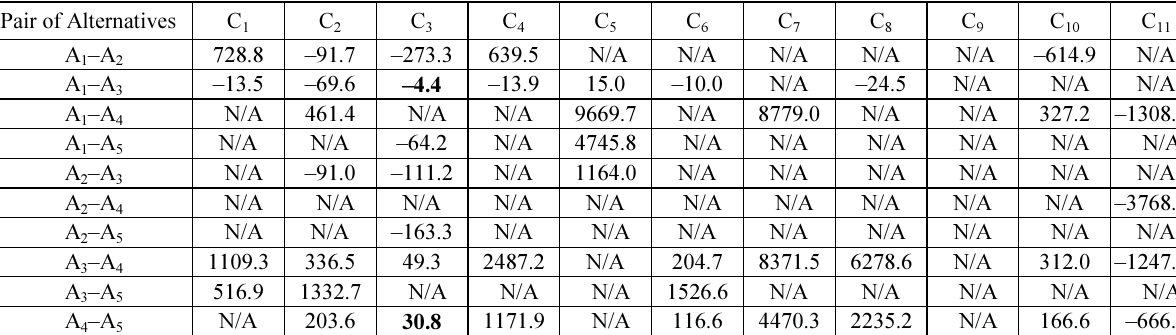
Table 11. All possible δ / k,i,j values (relative change in criteria weights) Pair of Alternatives C